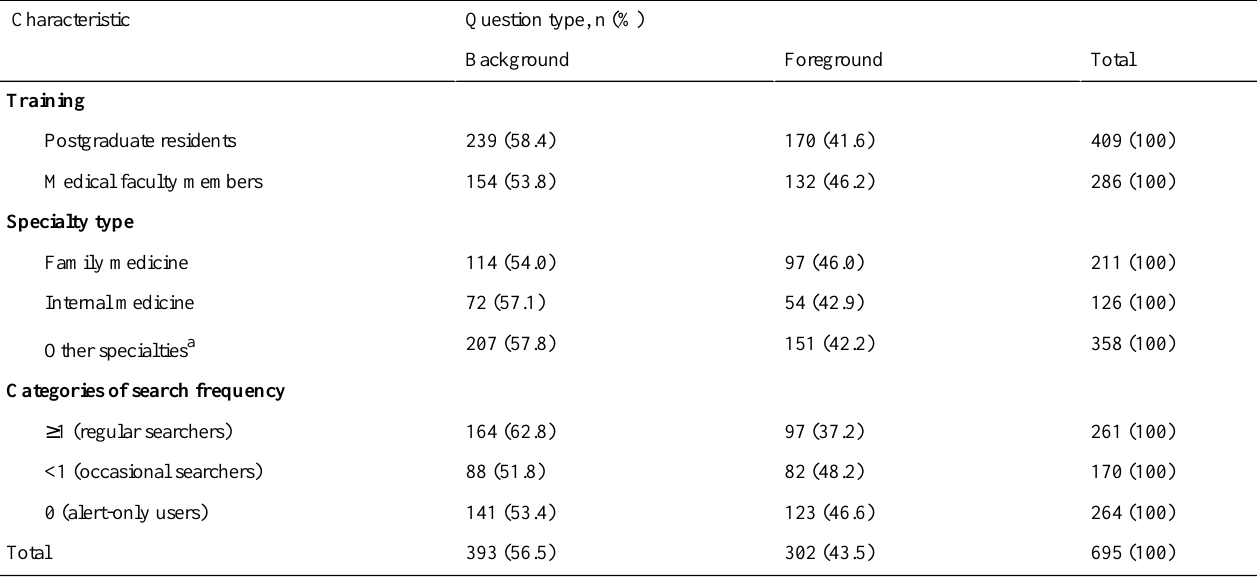
Table 2. Background versus foreground queries with respect to characteristics of